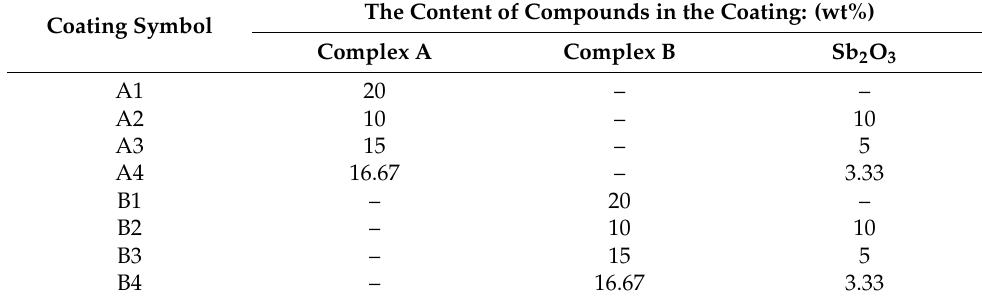
Table 1. Coatings compositions and designation of